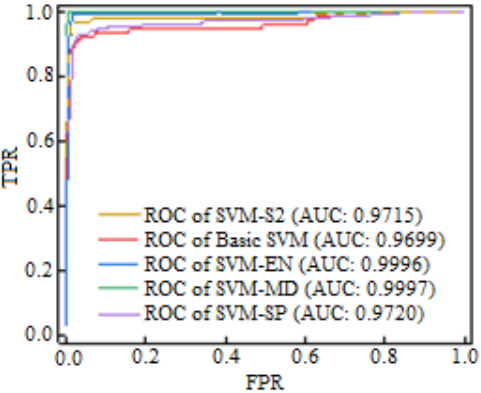
Figure 9. ROC curves for the models for defect detection.